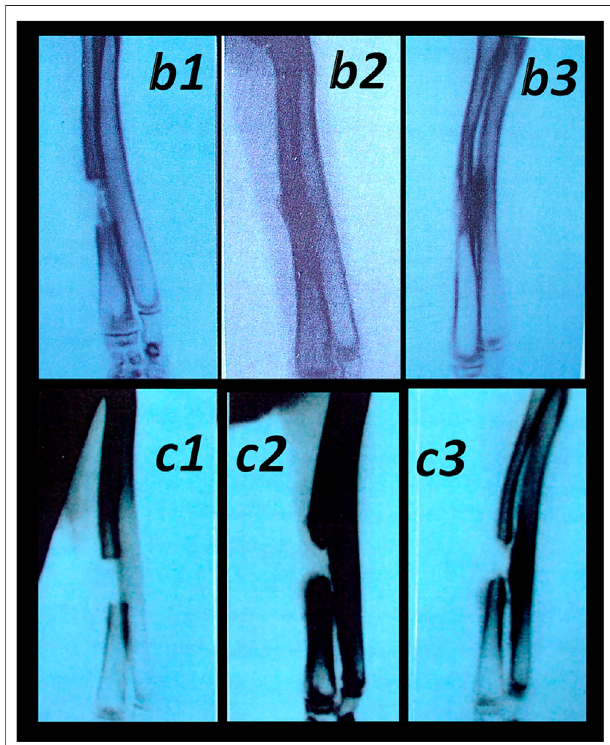
FIGURE 13 | Healing of the segmental osteoperiosteal bone defect (0.8 cm, in the middle of the left radius) in rabbits (Sebecic et al., 1999). Incompletely healed defect in all controls (assessed during 6 weeks, in 2- weeks intervals ( c1 (week 2), c2 (week 4), and c3 (week 6)). Pentadecapeptide BPC157bene fi cialeffect wasconsistently obtained(either percutaneously given locally (10 μ g/kg) into the bone defect, or applied intramuscularly (intermittently, at postoperative days 7, 9, 14, and 16 at 10 μ g/kg) or continuously (once per day, postoperative days 7 – 21 at 10 microgor10 ng/kg))( b1 (week2), b2 (week4),and b3 (week6)).Comparative regimens included percutaneous administration of autologous bone marrow locally (2 ml, postoperative day 7) as well as an autologous cortical graft insertedinthebonedefectimmediatelyafteritsformation.Saline-treated(2 ml intramuscularly (i.m.) and 2 ml locally into the bone defect), injured animals were used as controls (Sebecic et al., 1999).